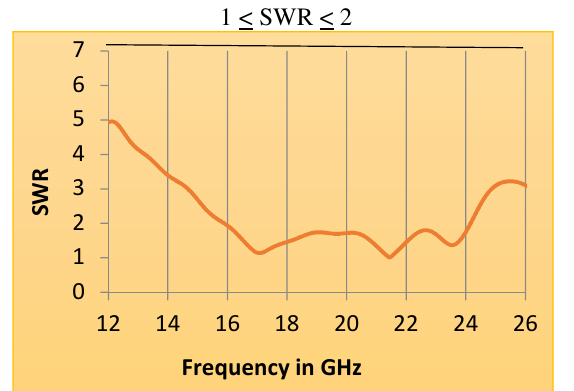
FIG. 6.VSWR OF THE ANTENNA